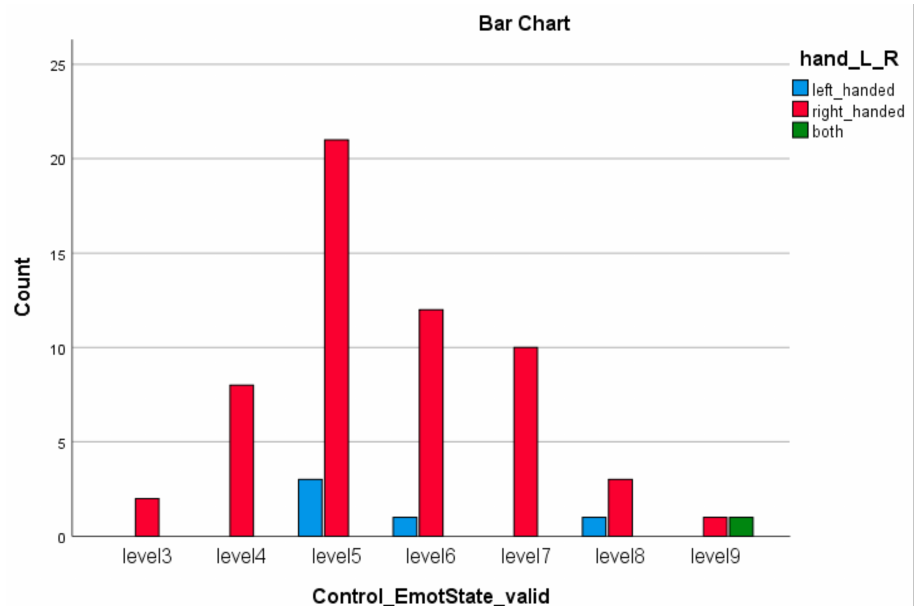
Figure 9. Control dimension of emotion scores versus handedness (right or left-handed participants) in the